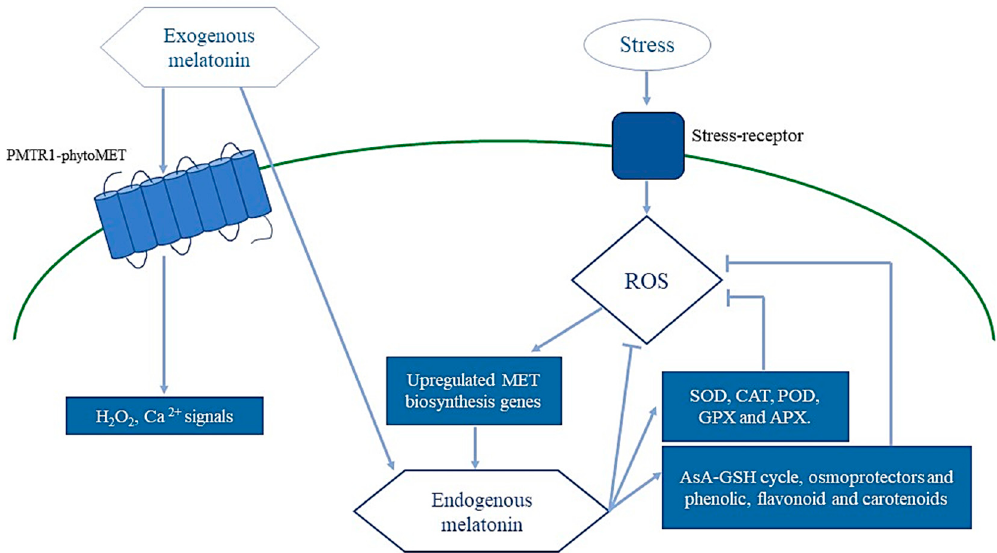
Figure 2. Interaction between melatonin (MET) and reactive oxygen species (ROS). ROS upregulates MET biosynthesis genes and enhances MET endogenous levels. MET can act as a ROS scavenger and controlled ROS levels through the melatonin-mediated induction of redox enzymes, such as SOD, CAT, POD, GPX and APX, and representative antioxidant representative non-enzymatic antioxidant compounds such as GSH and AsA (AsA-GSH cycle), osmoprotectants, and phenolic, flavonoid and carotenoid compounds. Similarly, the exogenous MET interacts with its receptor (CAND2/PMTR1), which appears to be melatonin-induced, resulting in the activation of responses against stressors are feed into a feedback mechanism with different regulating elements that belong to the redox network, such as ROS and RNS [42].